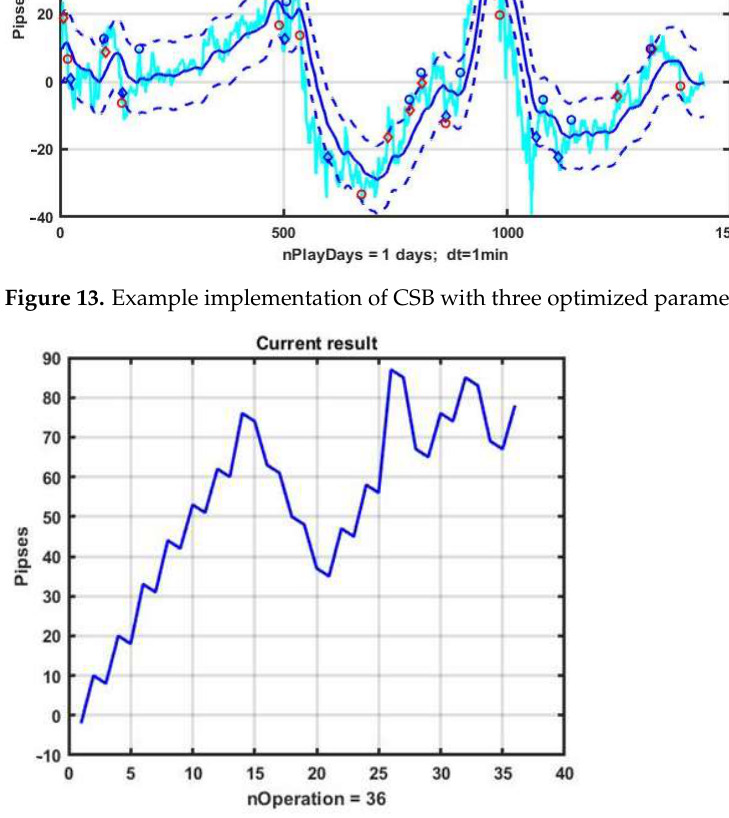
Figure 14. Performance of CSB with three optimized parameters.